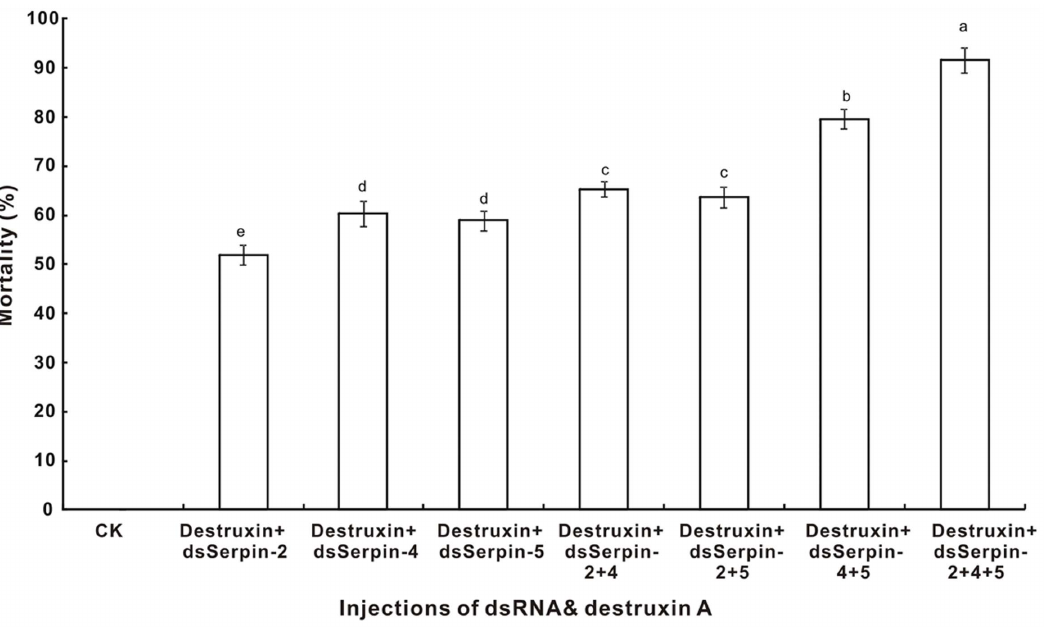
Figure 11. Insecticidal efficacy of destruxin A and serpin knockdown on larvae of Plutellaxylostella . Each treatment was injected with 2 m l of a solution containing 200 m g/ml (LC 50 ) destruxin A and a total of 5 m g dsRNA. The control treatment was injected with 2 m l of PBS buffer. Percentage mortality 24 h after treatment was calculated. Each value was shown as values 6 S.E.M of three independent experiments. Significant differences were indicated with different letters at P , 0.05.